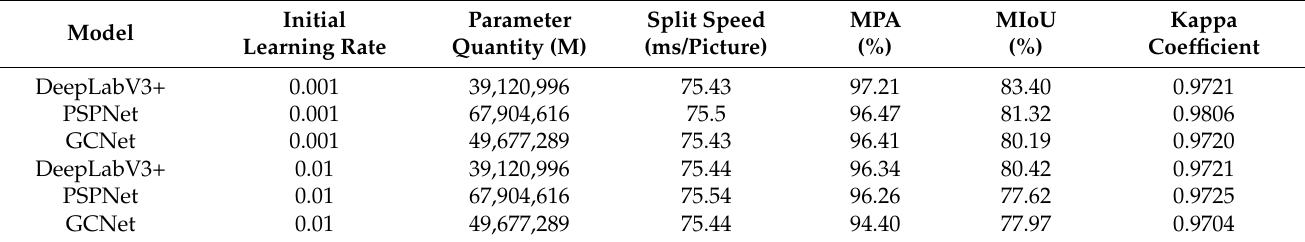
Table 2. Segmentation performance of the models.